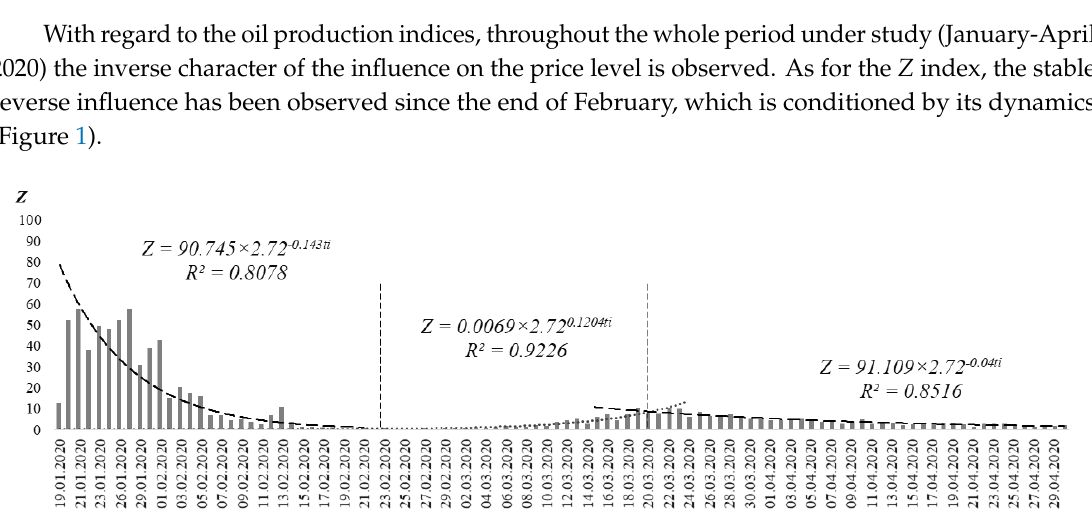
Figure 1. Disease to recovery ratio in the world during the period of COVID-19 spread.